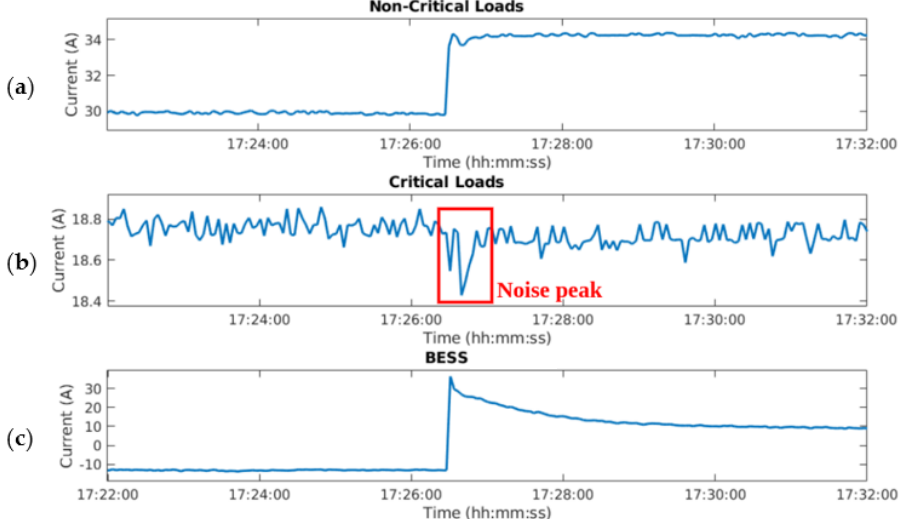
Figure 6. ( a ) sudden change in the currents through the non-critical loads; ( b ) measurement error caused by an approximately 40 A change in the DC current of the BESS; ( c ) sudden change in the currents through BESS.